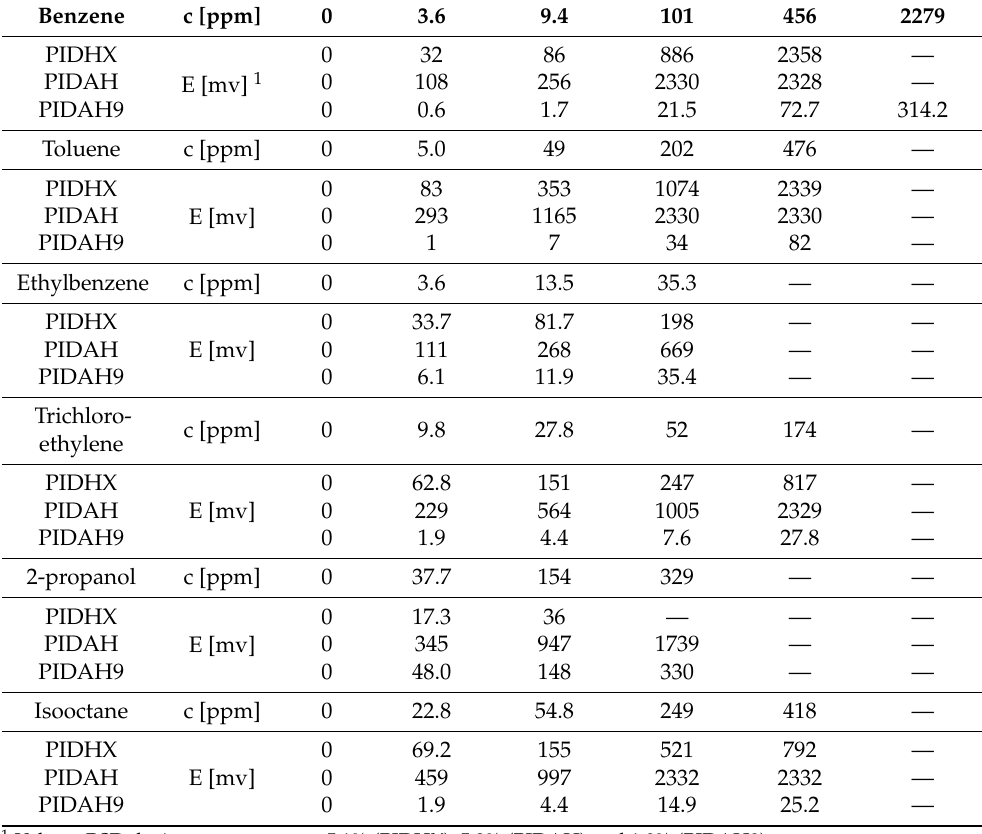
Table 4. Overview of voltage values recorded at testing sensors’ response to selected